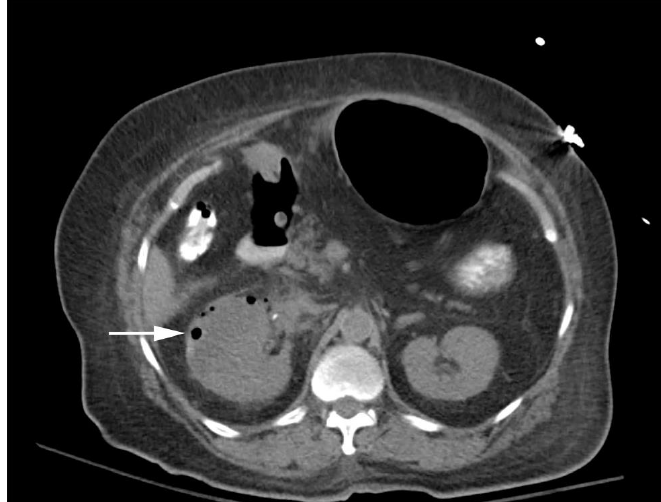
Image 2. Computed tomography of the abdomen and pelvis showing an enlarged right kidney with perinephric stranding and air in the renal cortex (white arrow) consistent with emphysematous